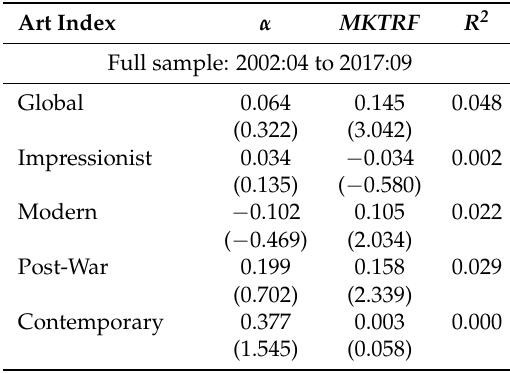
Table 3. The table reports the results of time-series regressions of the monthly returns associated with each art index on the excess returns of the value-weighted market portfolio (MKTRF). α is expressed as a percentage per month, and Newey–West t -statistics are reported in parentheses. Note that returns for the contemporary art index begin in